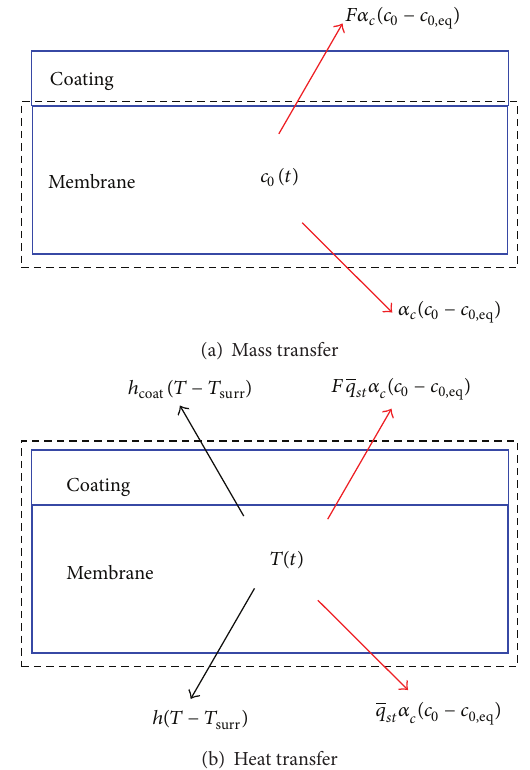
Figure 8: Fluxes used in heat and mass transfer when coating is